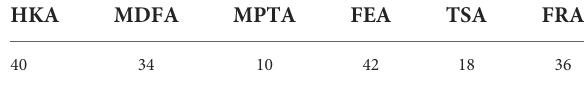
TABLE 3 Outlier rates of component alignment